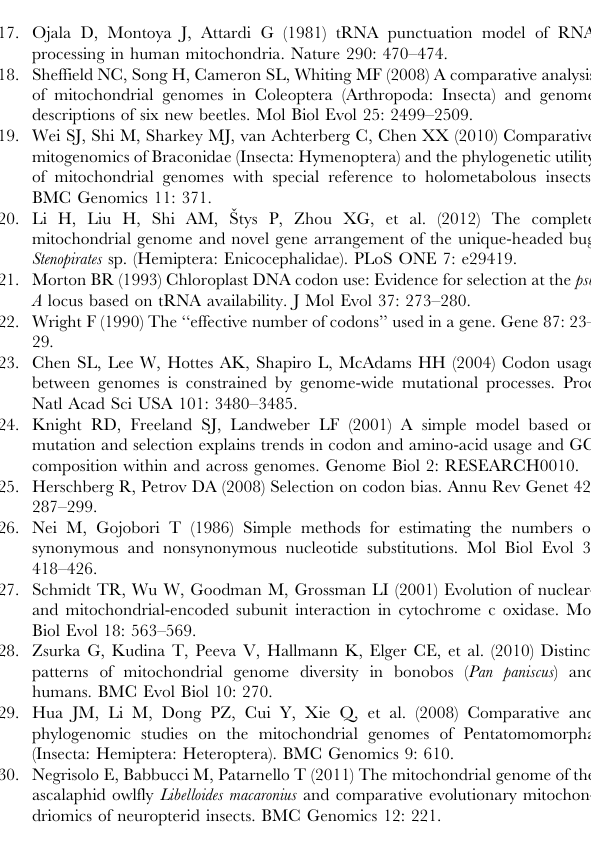
Figure S3 Inferred secondary structure of tRNA fami- lies in six nabid mtDNAs. The nucleotide substitution pattern for each tRNA family was modeled using as reference the structure determined for G. annulatus. The identical nucleotides in all six nabid mtDNAs are showed by grey circles. Not conserved nucleotides are highlighted by blue circles. The tRNAs are labeled with the abbreviations of their corresponding amino acids. Inferred Watson-Crick bonds are illustrated by lines, whereas GU bonds are illustrated by dots. Figure S4 Alignment of tRNA families ( trnA - trnL1 ) in six nabid mtDNAs. The loop regions are highlighted by the black pane. Figure S5 Alignment of tRNA families ( trnL2 - trnV ) in six nabid mtDNAs. The loop regions are highlighted by the black pane. Figure S6 Nucleotide variation in six nabid mitochon- drial rRNAs. Figure S7 Mapping various traits onto the phylogenetic tree of six damsel bugs. Ecological, morphological and mitogenomic traits are mapped onto the phylogenetic tree inferred from the mitogenomic data. Table S1 Structural features of six nabid mitogenomes.